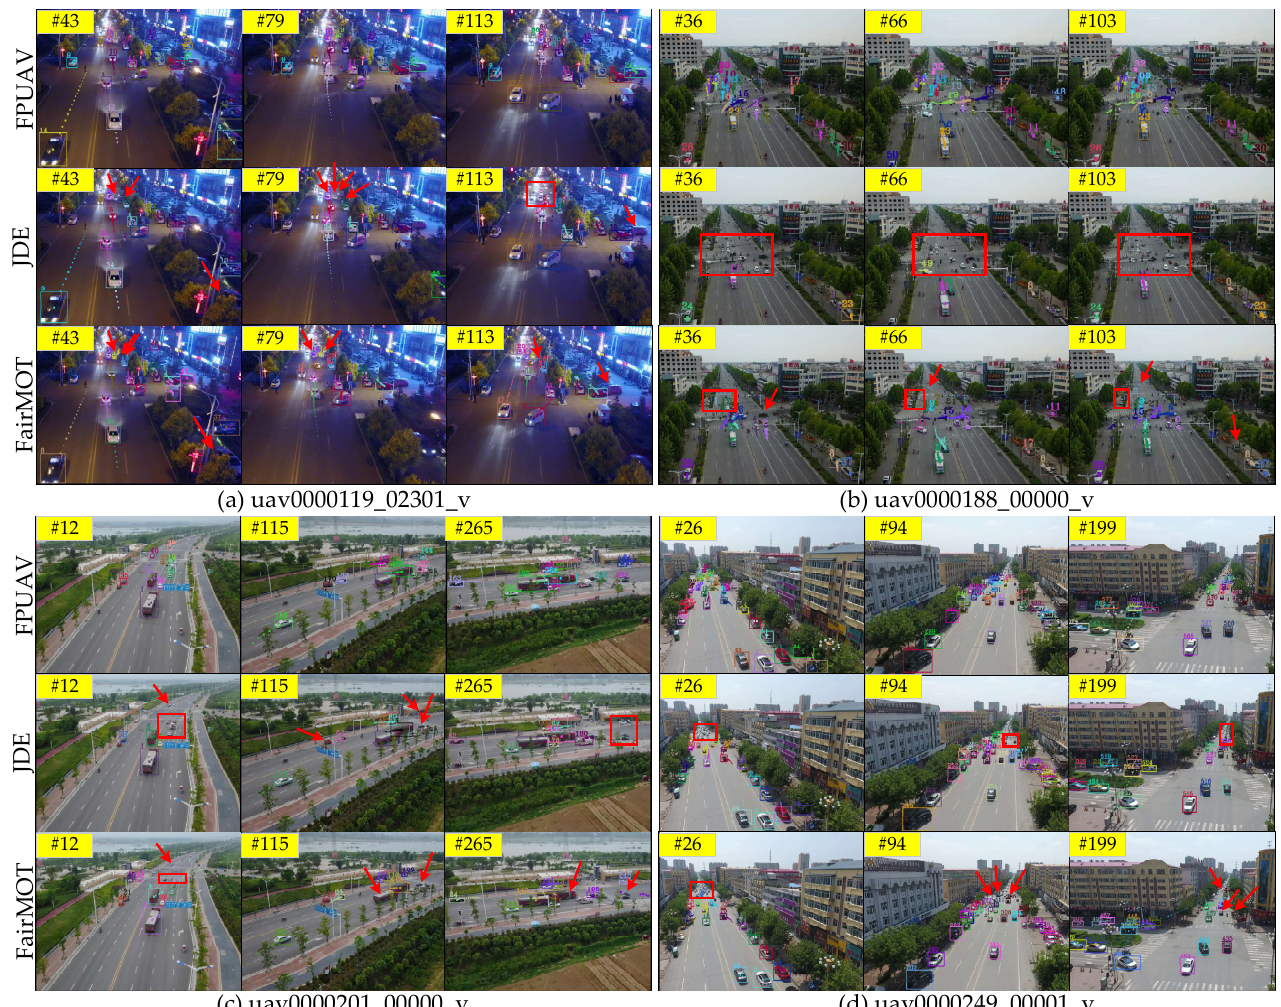
Figure 10. Qualitative analysis of the FPUAV compared with JDE and FairMOT. Red arrows mark missing targets, and red boxes are areas where many targets are